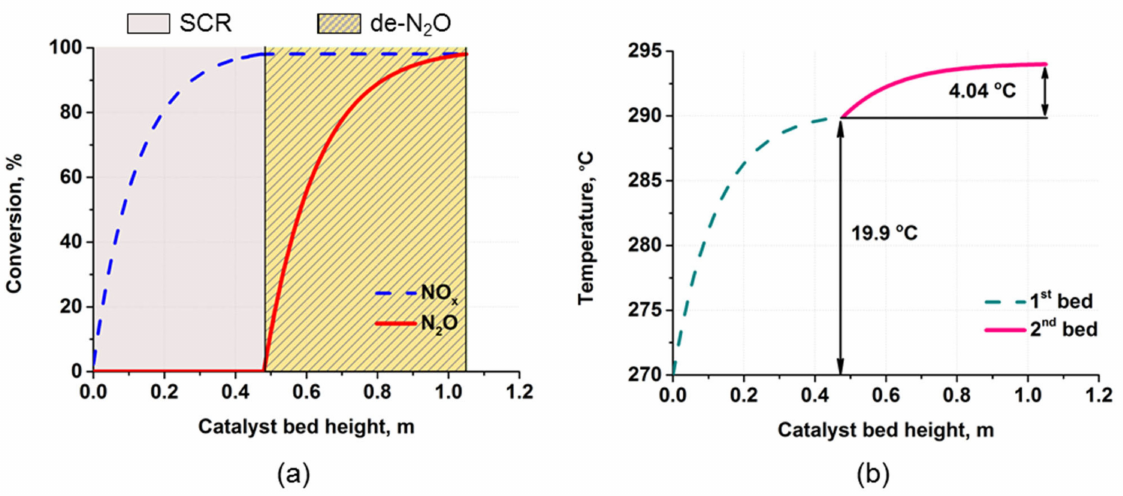
Figure 4. Conversion ( a ) and temperature ( b ) profiles along the bed heights at T in g = 270 ◦ C and Q = 58,670 m 3